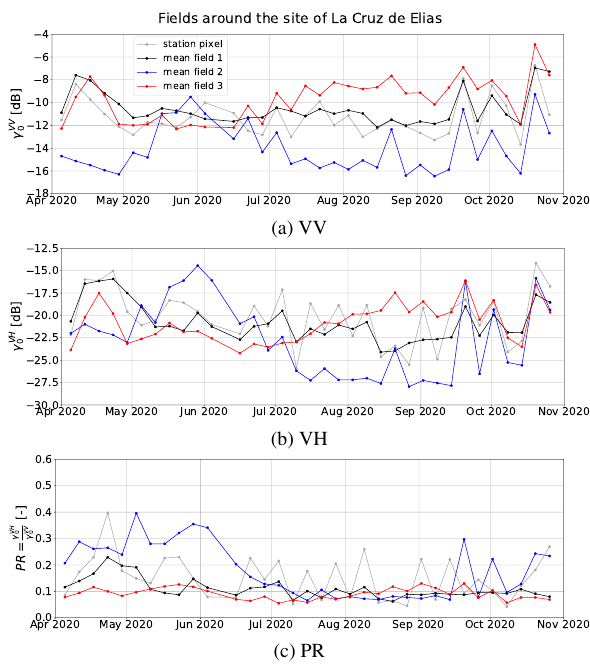
Figure 3. Time series of mean SAR parameters over three fields around the station of La Cruz de Elias. The time series from April to October 2020 of γ V V 0 in dB, γ V H 0 in dB and PR are shown respectively in Figure 2a, 2b and 2c. In the graphs the grey line shows the pixel in which lays the measurement station, the black line depicts the field 1, the blue line the field 2, and the red line the field